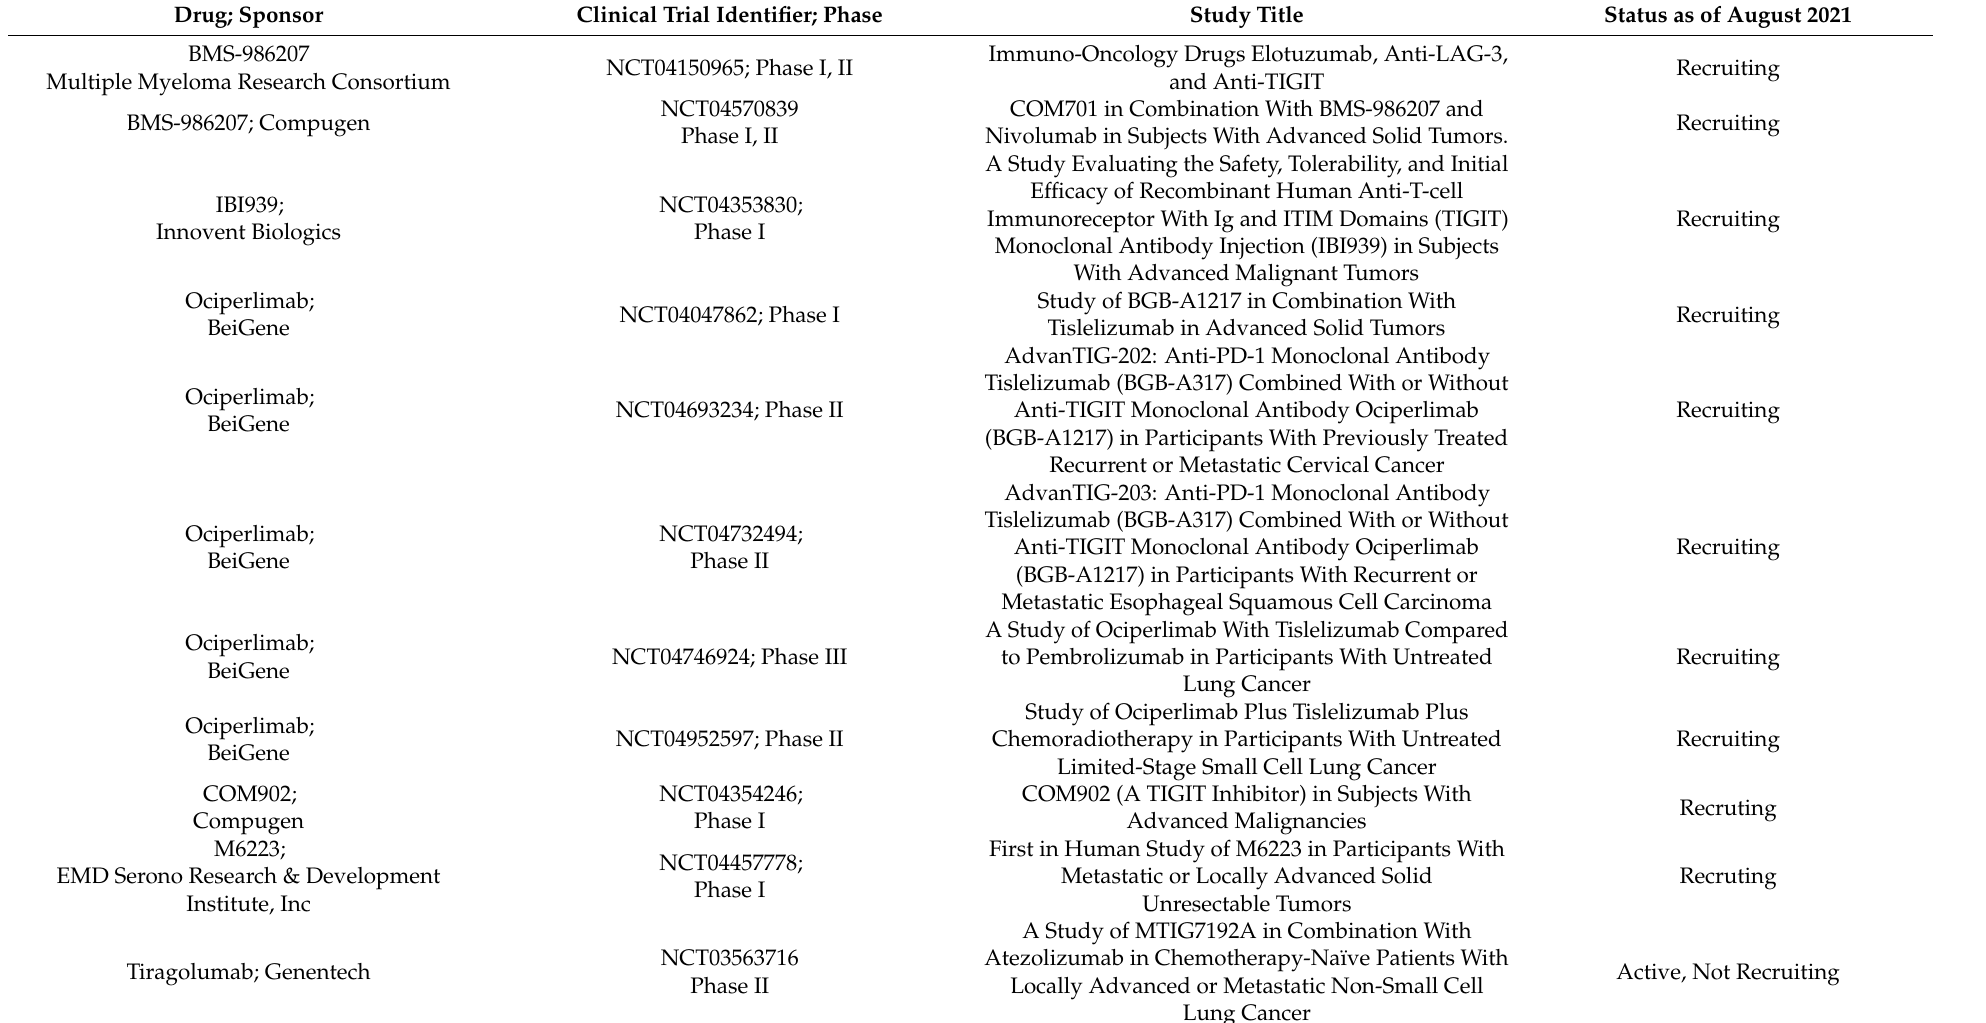
Table 5. Ongoing clinical trials evaluating efficacy and safety of anti-TIGIT